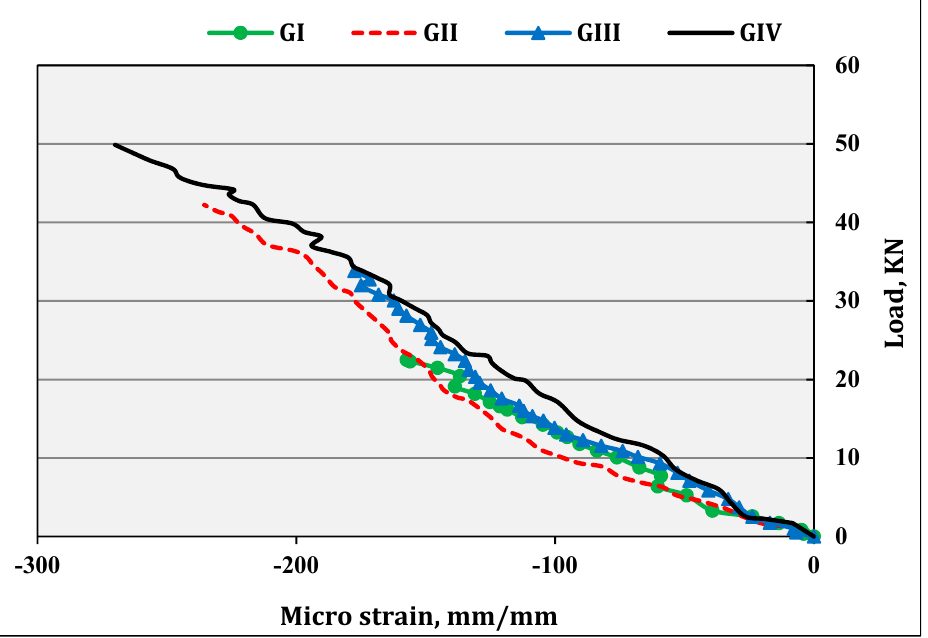
Figure 14. Load vs. compression strain in concrete blocks at mid-span for an average of tested groups.